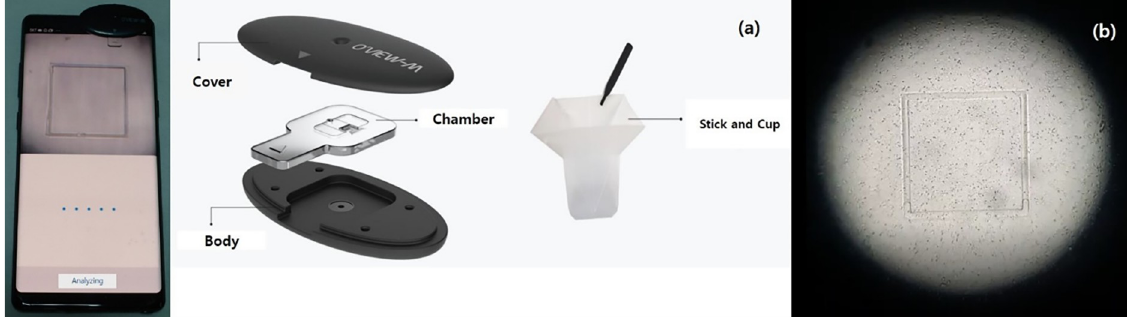
Fig 1. Installed OviewM and View of Sperm analysis using Oview M. (a) Consist of Oview M (b) View of Sperm analysis using Oview M. https://doi.org/10.1371/journal.pone.0269894.g001 sperm mobility when measured by OVIEW-M tests (r = 0.893, p < 0.01) and standard micro-